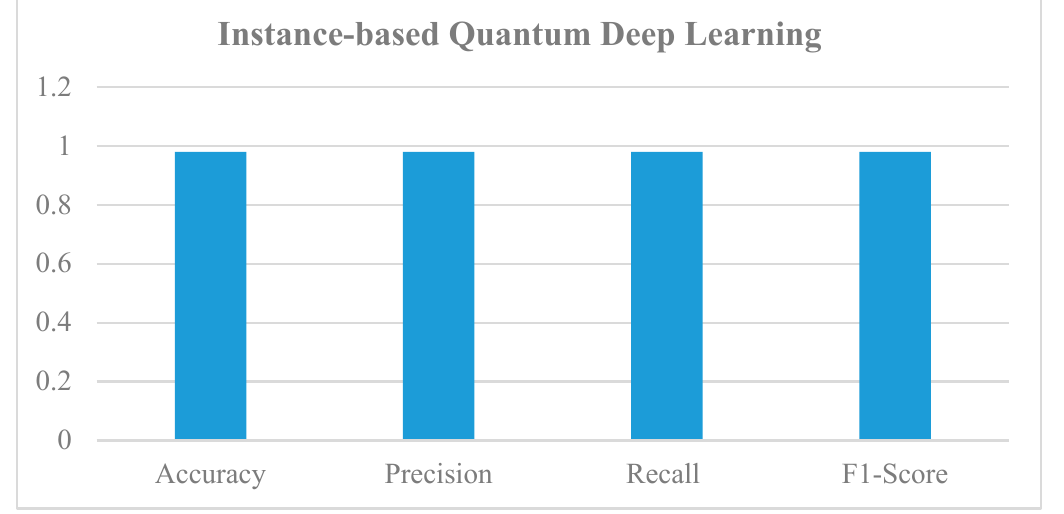
Figure 16. Graphical Representation of the Proposed QDL.